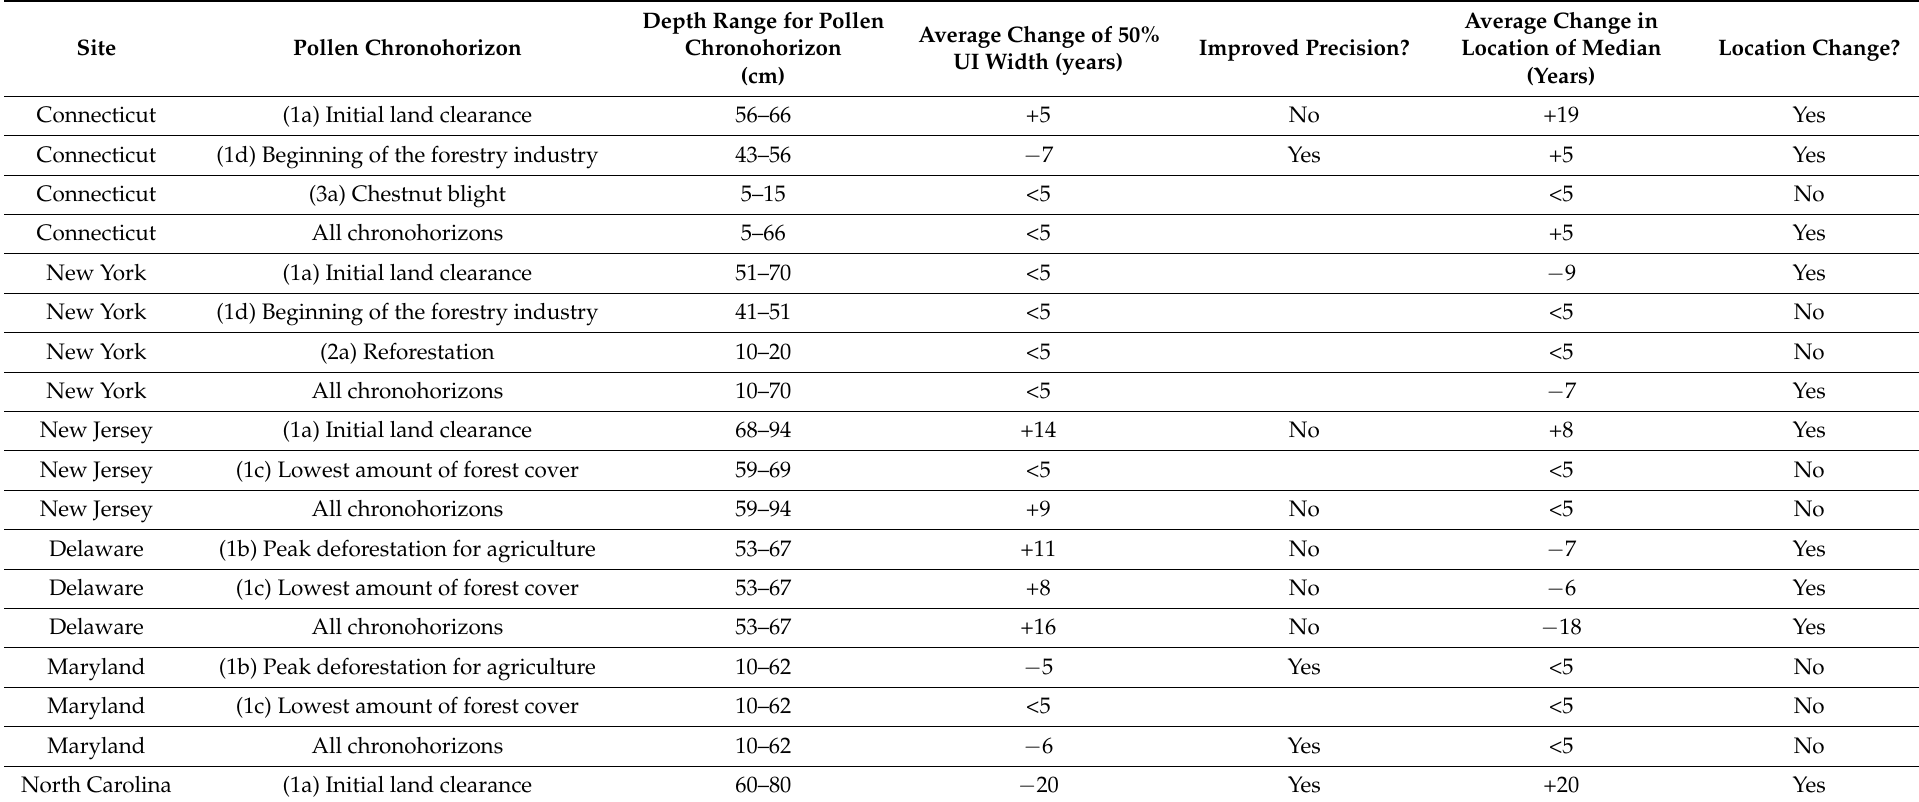
Table 4. Comparison of with pollen (WP) and no pollen (NP) age–depth models. Positive numbers in the columns titled “Average change of 50% UI width” represent a decrease in precision (widening) and negative numbers represent an increase in precision (narrowing). Average changes of <5 years are considered not to have changed. In the column titled “Average change in location of median”, positive numbers indicate that the addition of pollen caused the model to predict younger ages, while negative numbers indicate that including pollen caused the model to predict older ages for sediments in the depth range